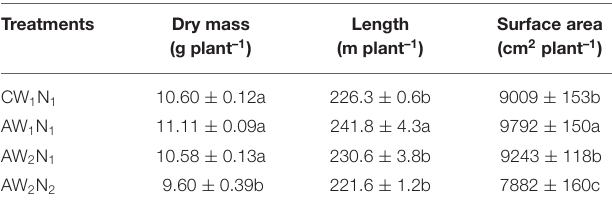
TABLE 2 | The effects of irrigation and N supply on the mass, length, and surface area of tomato roots under alternate partial root-zone drip N fertigation.